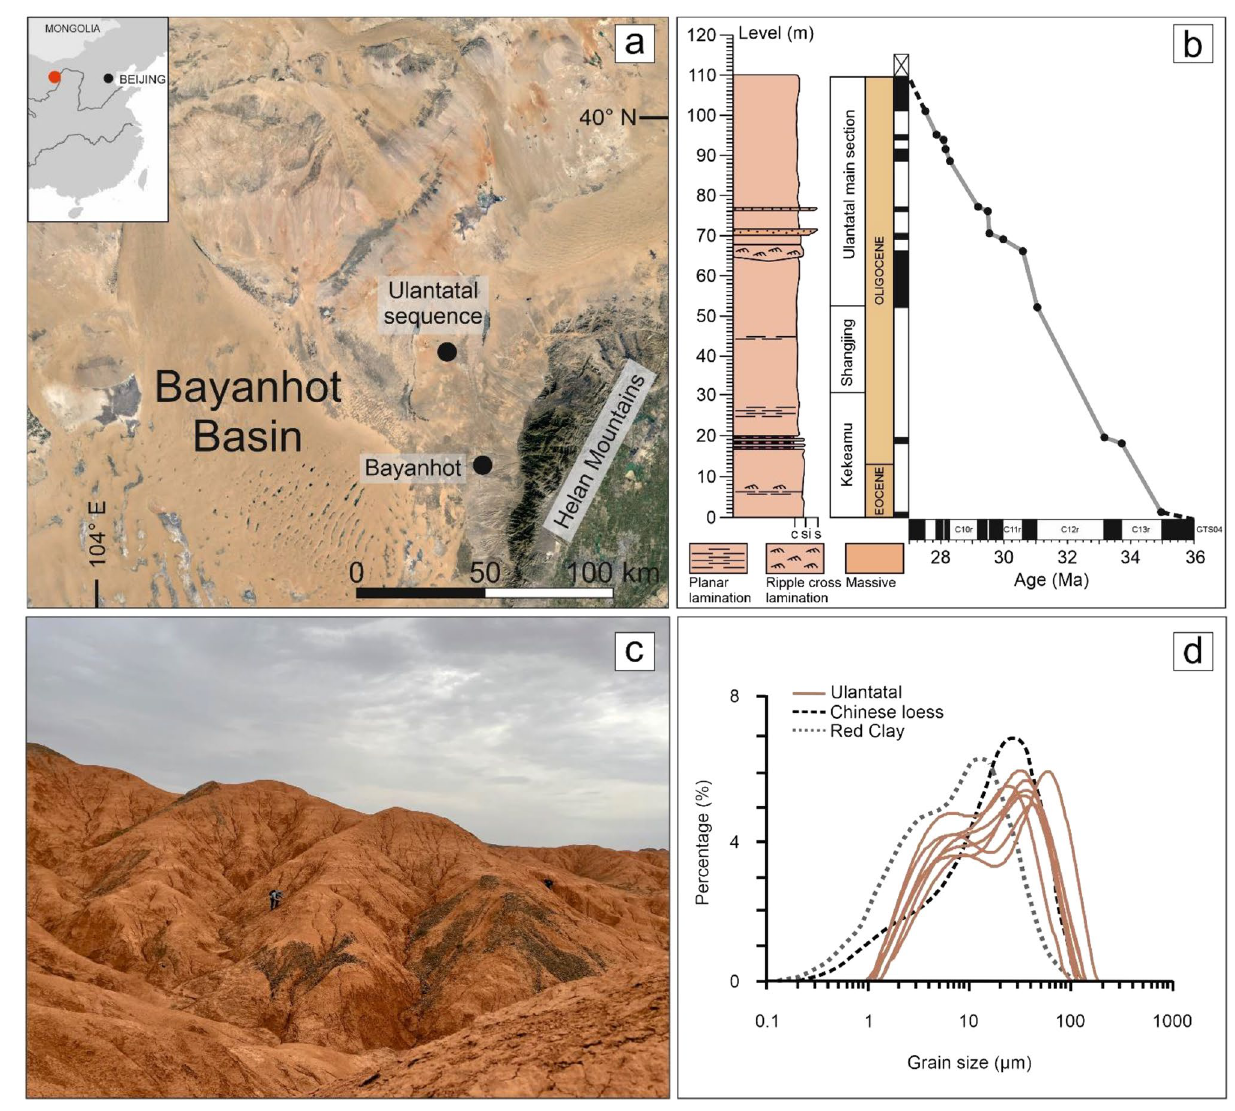
Figure 1. ( a ) A regional Google Earth Pro map (www. google. com/ intl/ en/ earth) of the Bayanhot Basin, also showing the location of the studied Ulantatal sequence. The satellite image was modified with CorelDRAW 2020 (www. corel draw. com) ( b ) A simplified lithological column of the Ulantatal sequence with subsections, sediment thickness, epochs and age-depth model. c Field view from the Kekeamu section where alternating more yellowish versus more reddish beds are visible. ( d ) Grain size distributions of selected samples from Ulantatal in comparison to Chinese loess and Red Clay. ( b , d ) are reproduced from 15